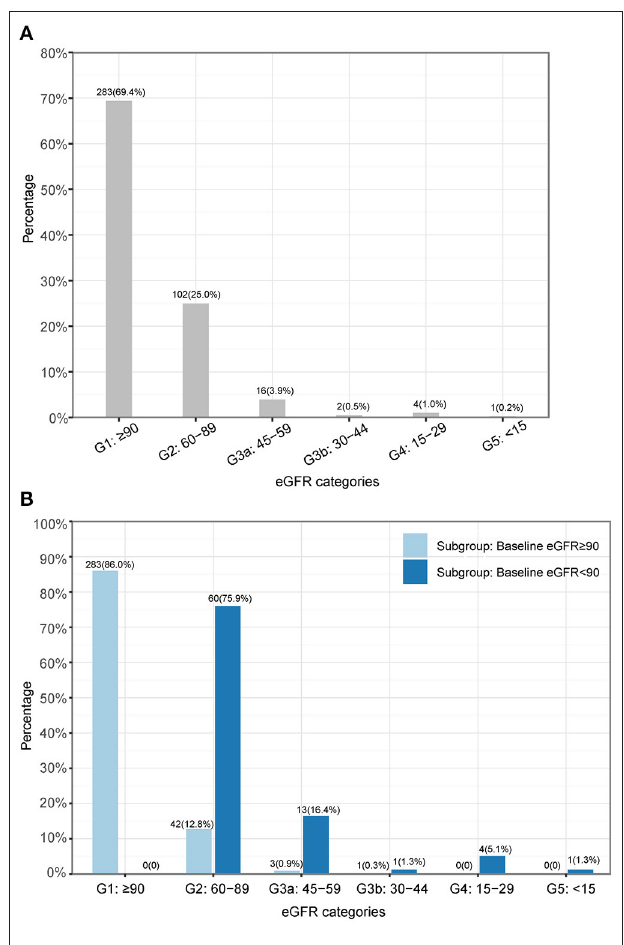
FIGURE 2 | The most severe renal dysfunction of each individual during follow-up. ( A ) Overall. ( B ) Subgroups. eGFR , estimated glomerular filtration